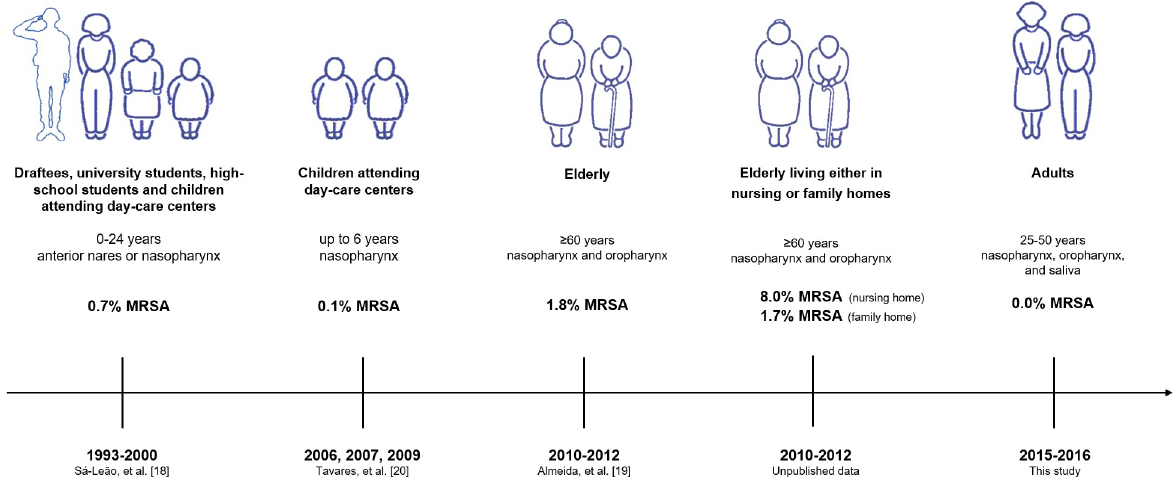
Fig 3. MRSA prevalence in the community in Portugal. Summary of studies performed among different populations of different age groups since 1993. For each study the age groups, sampling site and MRSA prevalence are indicated.